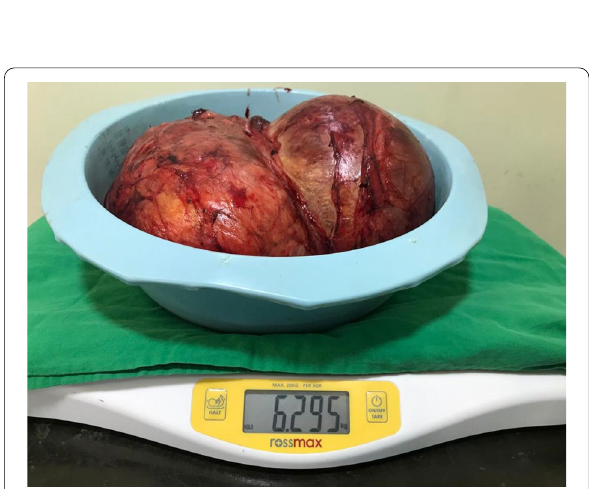
Fig. 7 Right-sided kidney with AML measuring 26 Renal tissue could not be separately visualized